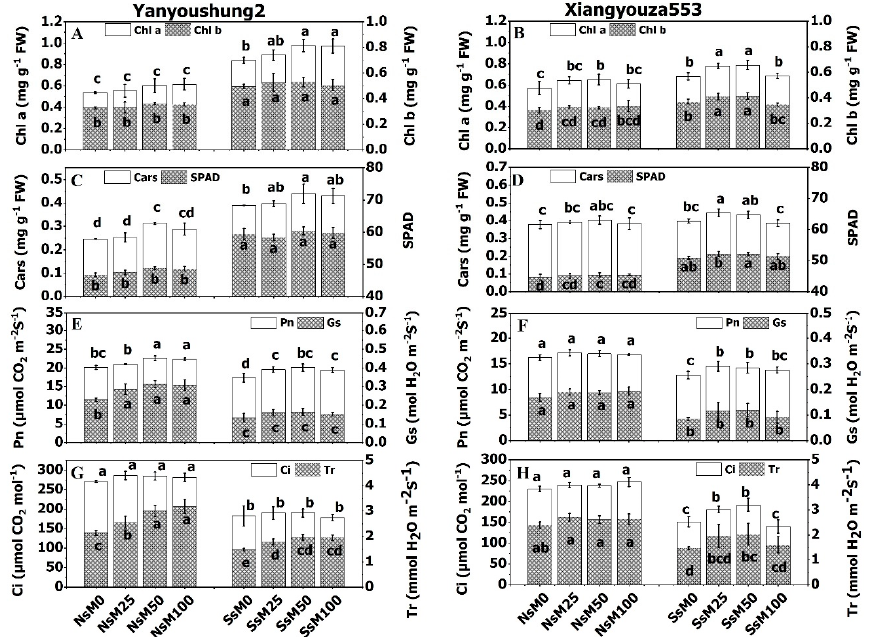
Figure 4. Response of two B. napus L. cultivars for chlorophyll a (Chl a), chlorophyll b (Chl b), carotenoids (Cars), soil and plant analyzer development (SPAD), net photosynthetic rate (Pn), stomatal conductance (Gs), intercellar CO 2 concentration (Ci), and transpiration rate (Tr) to seed priming with 0 µM (M0), 25 µM (M25), 50 µM (M50), and 100 µM melatonin (M100) under non-NaCl stress (Ns) and NaCl salt stress (Ss). ( A ) Chl a and Chl b of Yangyoushuang2; ( B ) Chl a and Chl b of Xiangyouza553; ( C ) Cars and SPAD of Yangyoushuang2; ( D ) Cars and SPAD of Xiangyouza553; (E) Pn and Gs of Yangyoushuang2; ( F ) Pn and Gs of Xiangyouza553; ( G ) Ci and Tr of Yangyoushuang2; ( H ) Ci and Tr of Xiangyouza53. Bars represent SD of three replicates. Different letters indicate significant differences among treatments ( p ≤ 0.05).